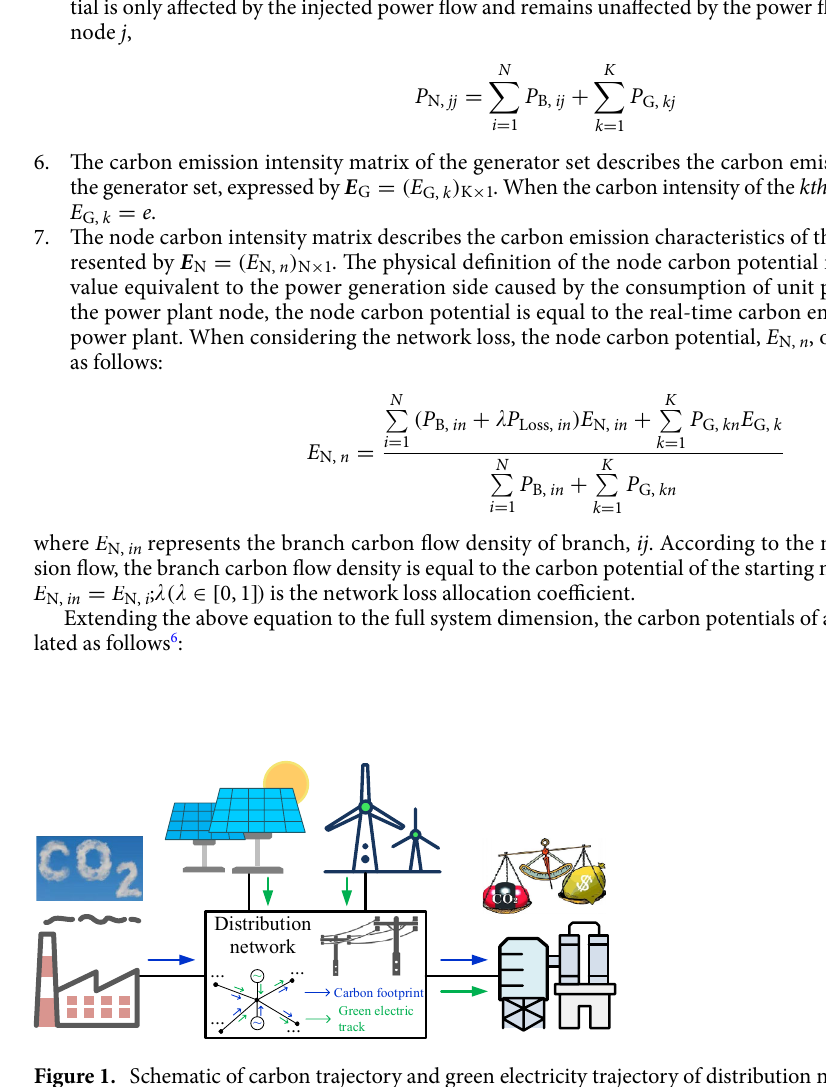
Figure 1. Schematic of carbon trajectory and green electricity trajectory of distribution